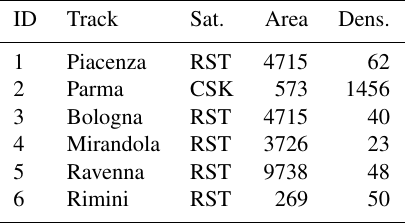
Table 1. The 6 tracks of processed radar with their area (km 2 ) and point density (dens.: pointskm − 2 ).